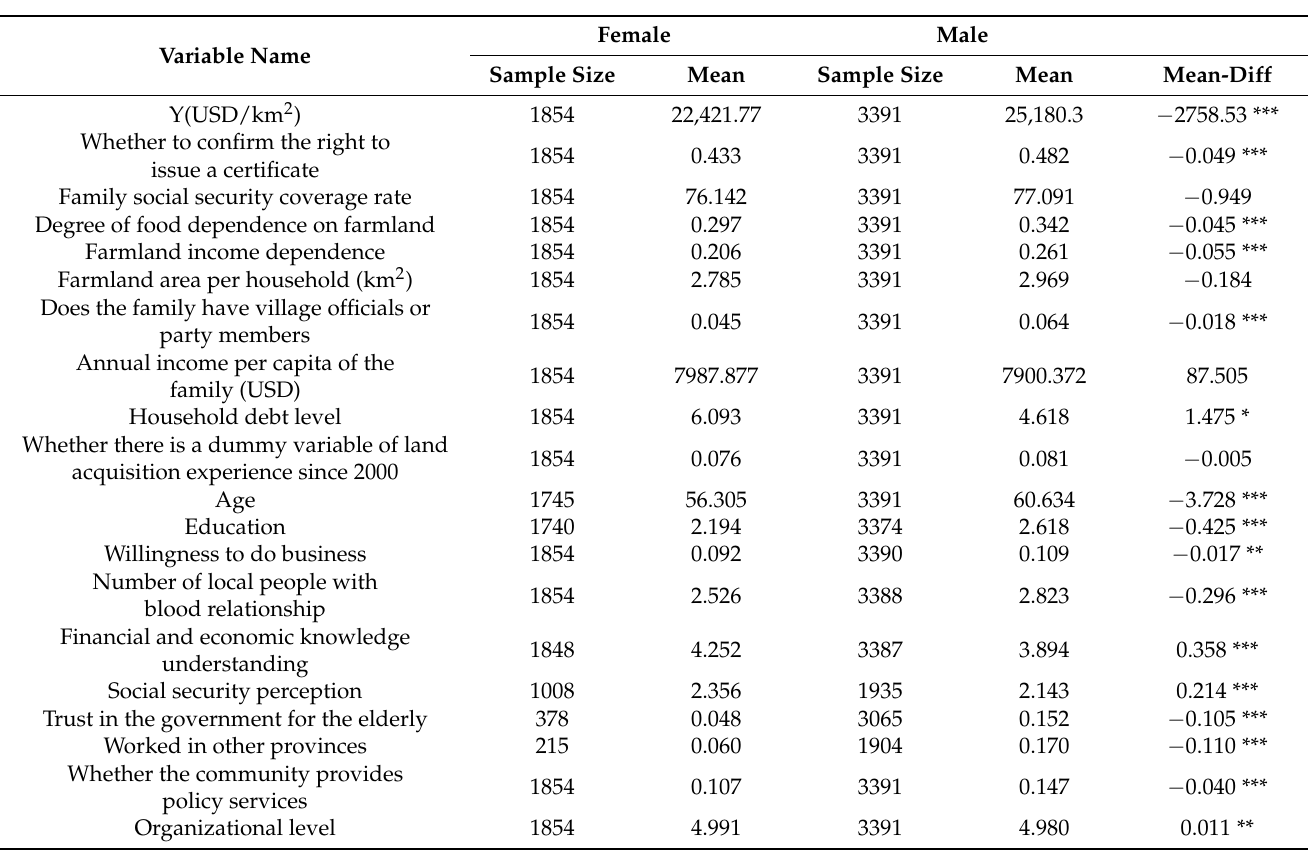
Table 3. Grouped mean t